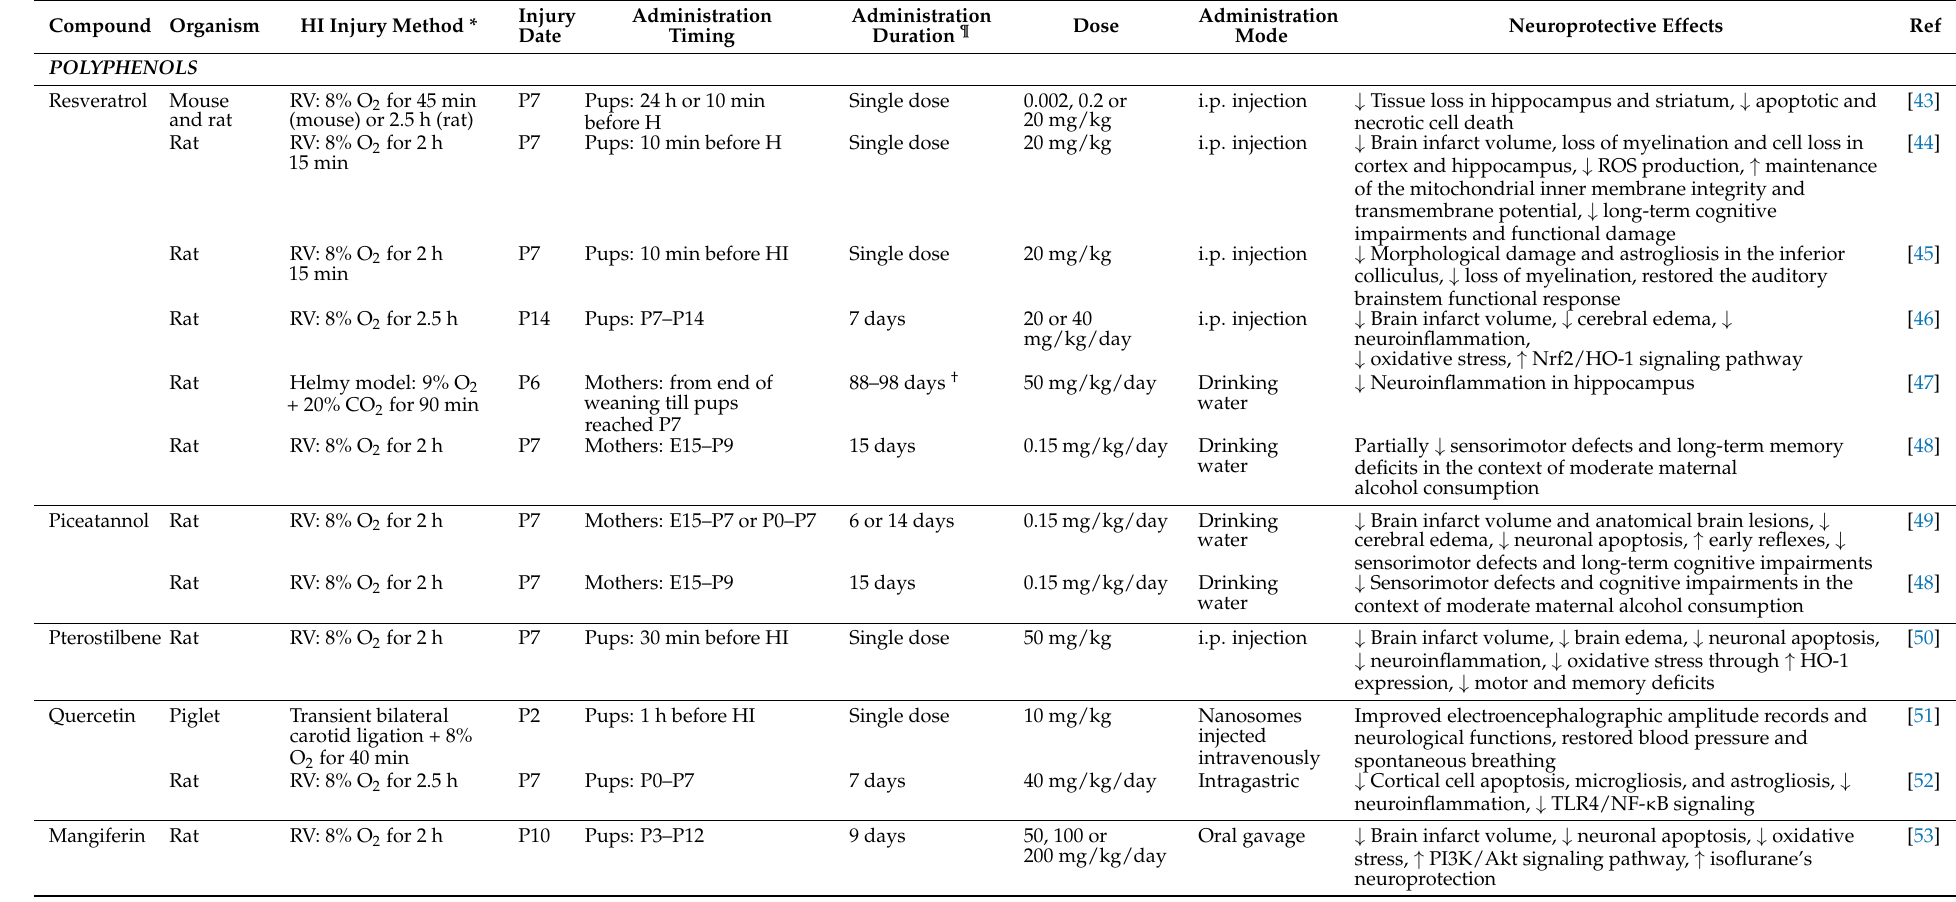
Table 1. Summary of the preclinical in vivo studies that have examined the neuroprotective effects of natural products administered before neonatal hypoxia–ischemia (HI) injury. Compound